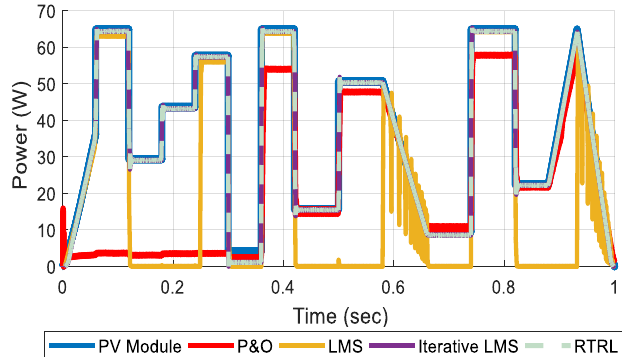
Figure 13. Results of the P&O, LMS, and RTRL controllers under conditions of variable irradiance and constant temperature.